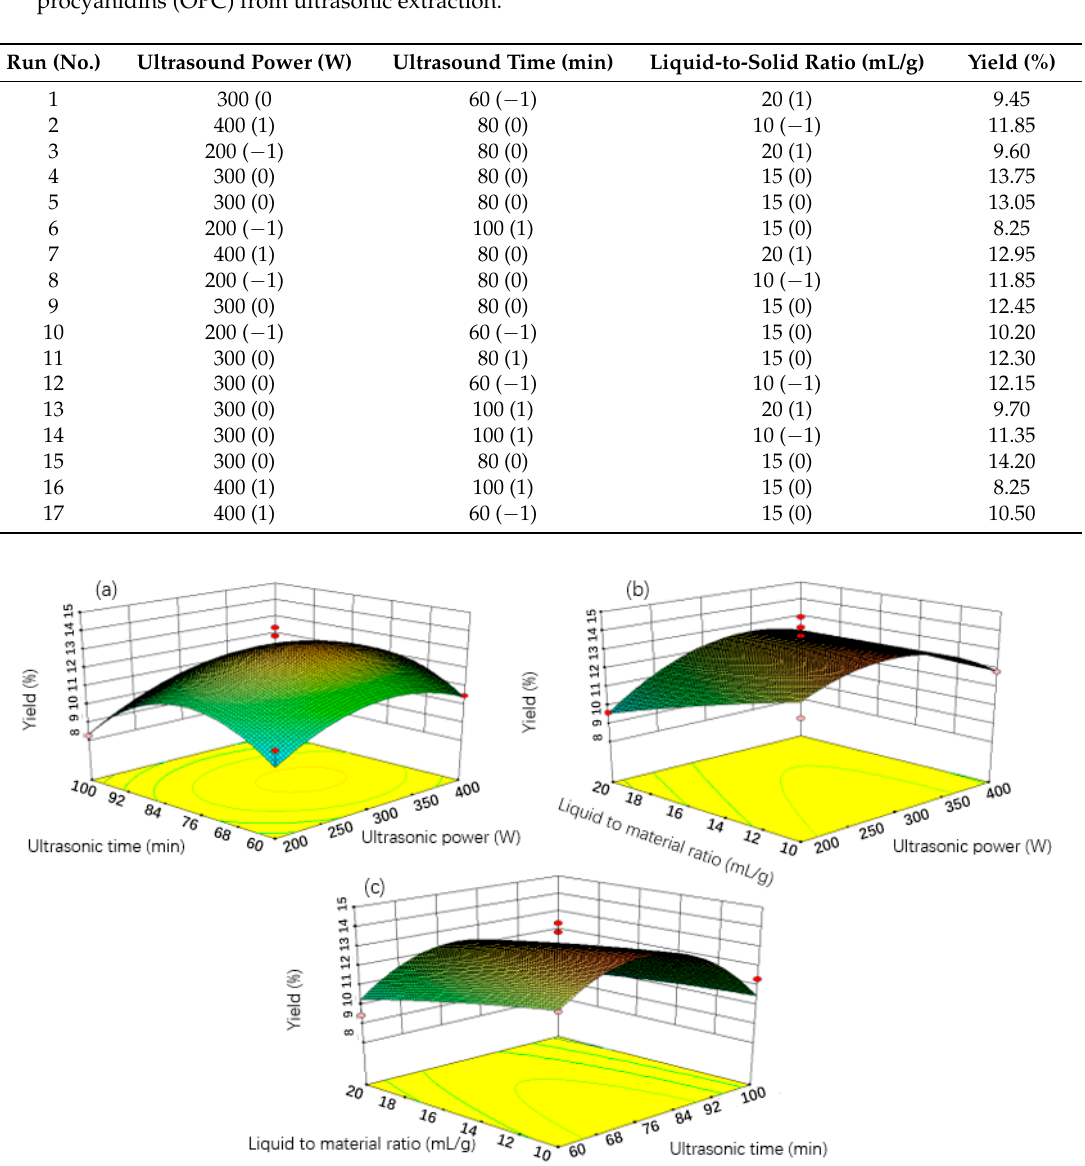
Figure 2. Response surface plots showing the operating parameter effects on extraction yield: ( a ) Ultrasonic time vs. ultrasonic power at fixed liquid-to-material ratio of 15 mL/g; ( b ) liquid-to-material ratio vs. ultrasonic power at fixed ultrasonic time at 80 min; ( c ) liquid-to-material ratio vs. ultrasonic time at fixed ultrasonic power of 300 W.